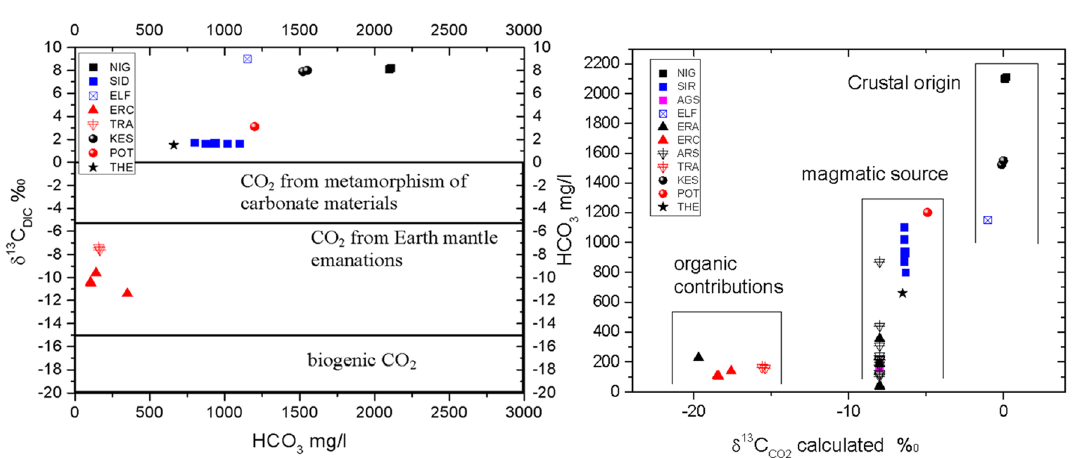
Figure 5. ( a ) δ 13 C DIC versus HCO 3 of the thermal waters for all studied areas. ( b ) δ 13 C CO2 calc versus HCO 3 of the thermal waters for the studied